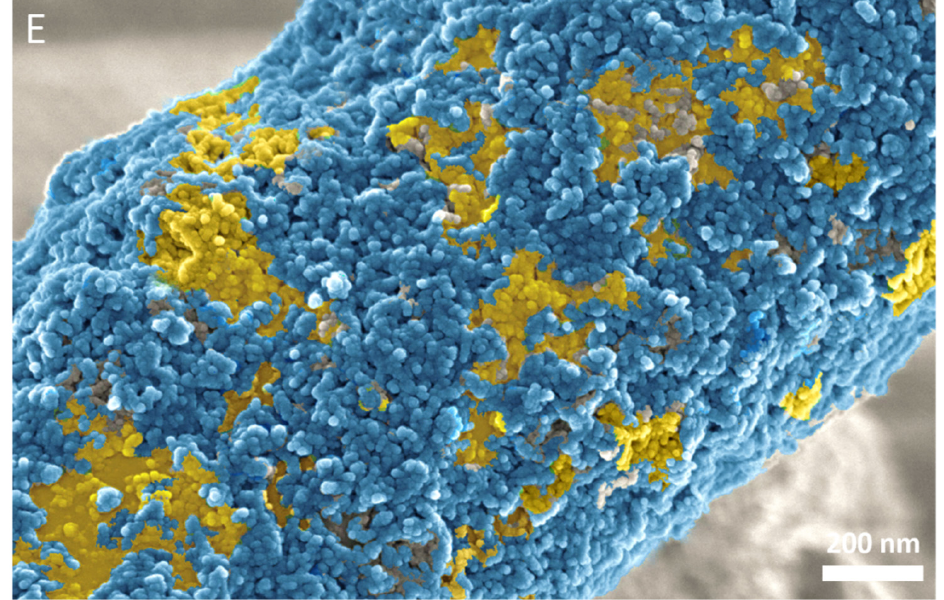
Figure 11. Colorized SEM image of: ( A ) non ‐ coated PDLLA/PLGA fiber, ( B ) PDLLA/PLGA/nHA, ( C ) PDLLA/PLGA/nZnO:Ag, ( D ) PDLLA/PLGA/nHA/nZnO:Ag after coating and ( E ) PDLLA/PLGA/nHA/nZnO:Ag after 24 h immersion in PBS medium at 37 ° C. Note PDLLA/PLGA/nHA/nZnO:Ag sample visible regions of nHA (yellow) and nZnO:Ag (blue).